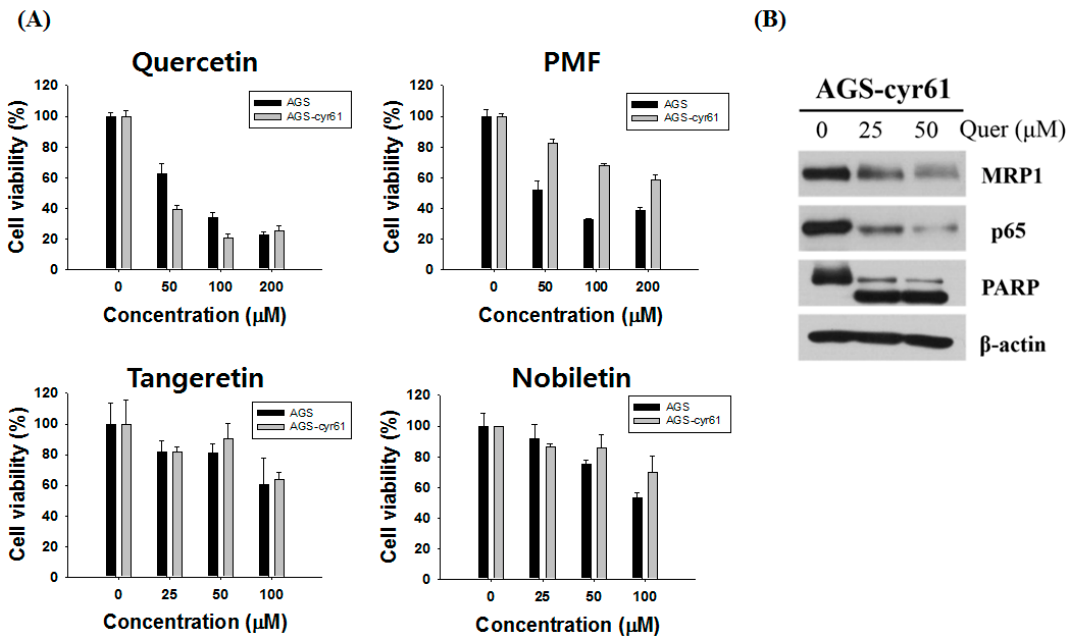
Figure 2. Effect of quercetin on the expression of drug resistance-related proteins in AGS-cyr61 cells. ( A ) Cell viability was determined based on the MTT assay against various flavones in AGS and AGS-cyr61 cells. Values are the means ± SD of four independent experiments. PMF: pentamethoxyflavone; ( B ) Western blot analysis of the effect of quercetin on drug resistance-related protein expression in AGS-cyr61 cells